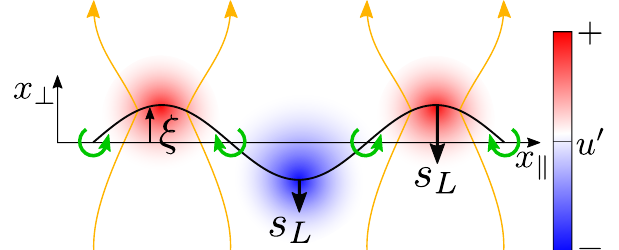
Figure 6. Flame-generated vorticity at a corrugated flame sheet—indicated by green circular arrows— increases and decreases flow speed, as indicated by the red and blue areas as well as the orange stream tubes. Variations of flame speed as a result of flame stretch are indicated by downward pointing small arrows of various